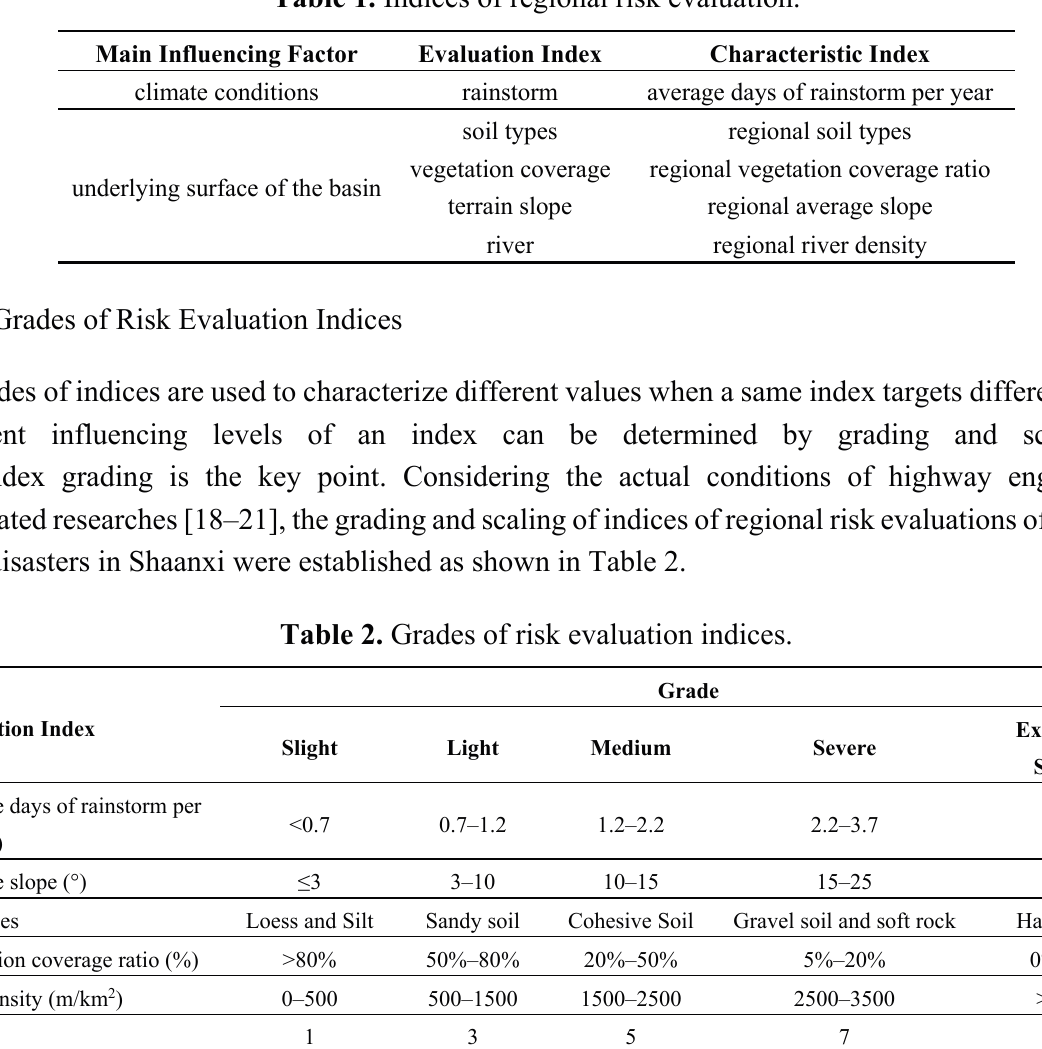
Table 1. Indices of regional risk evaluation.